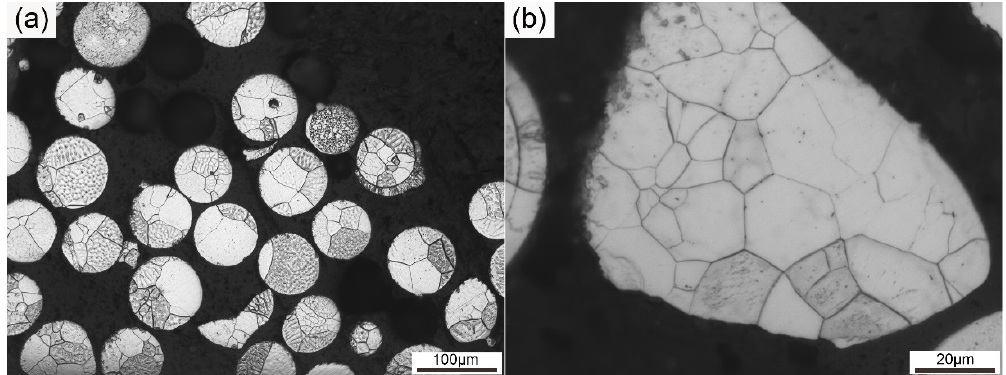
Figure 1. Optical microscope (OM) graphs of the pre-alloyed powders at ( a ) low and ( b ) high magnification.